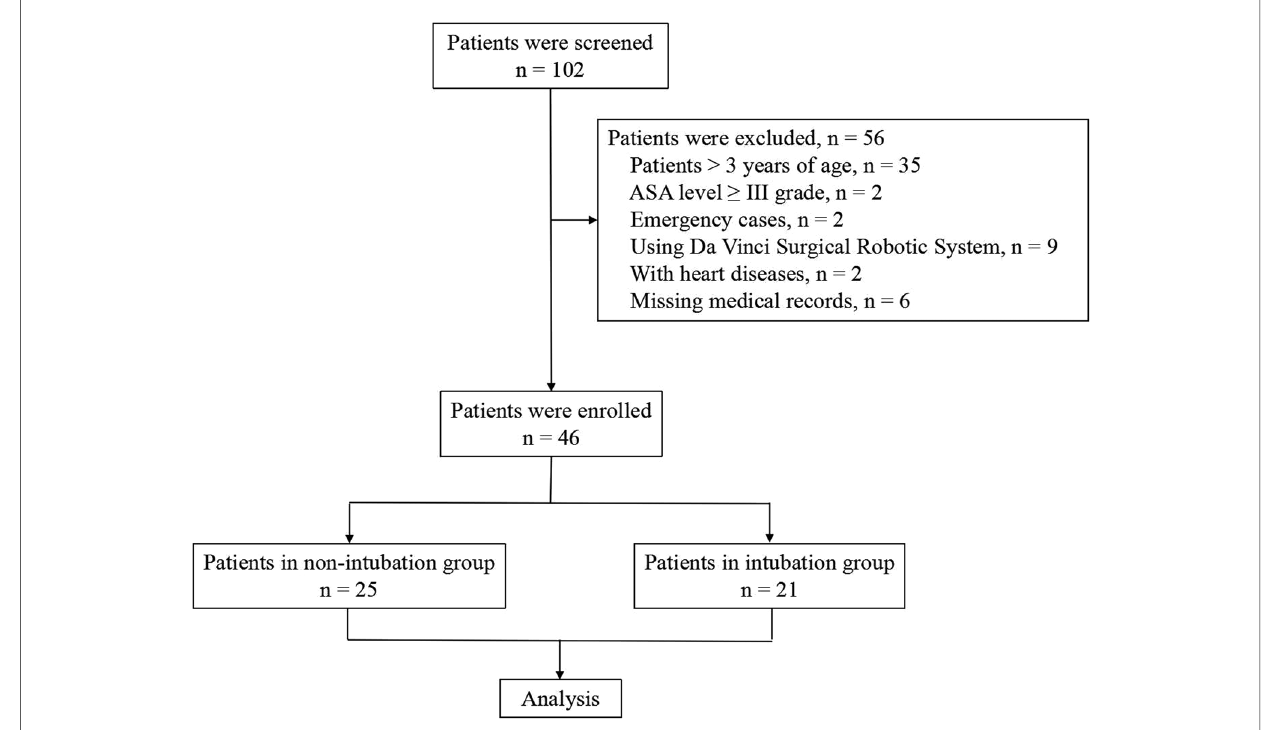
FIGURE 1 Patient inclusion and exclusion criteria for retrospective